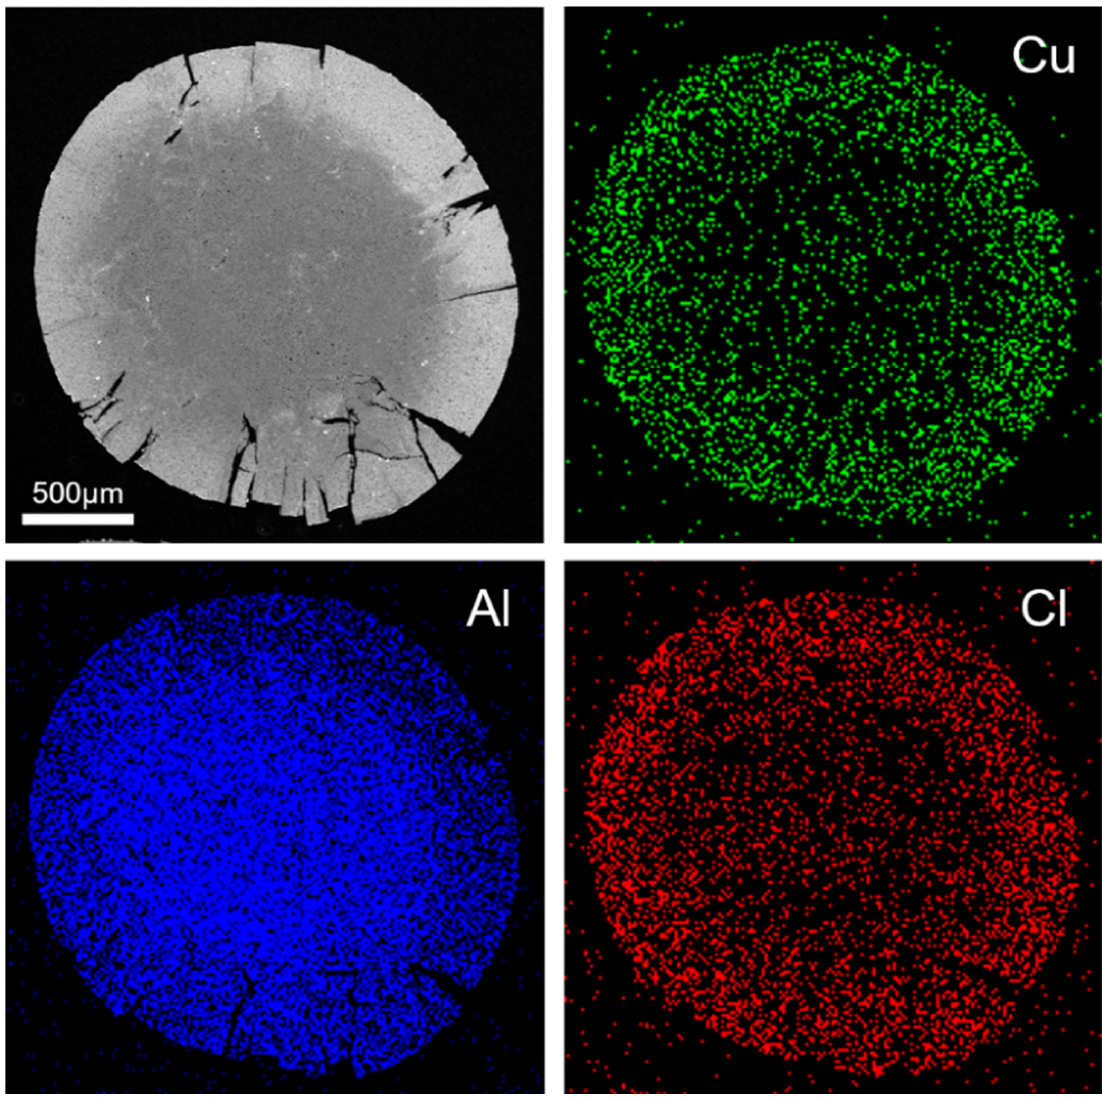
Figure 3. SEM image and EDS mapping of i -Cu(I)/ θ -Al 2 O 3 -500 showing that Cu (green) and Cl (red) were dispersed over the sample’s outer surface. Al (blue) was concentrated in the interior of one.